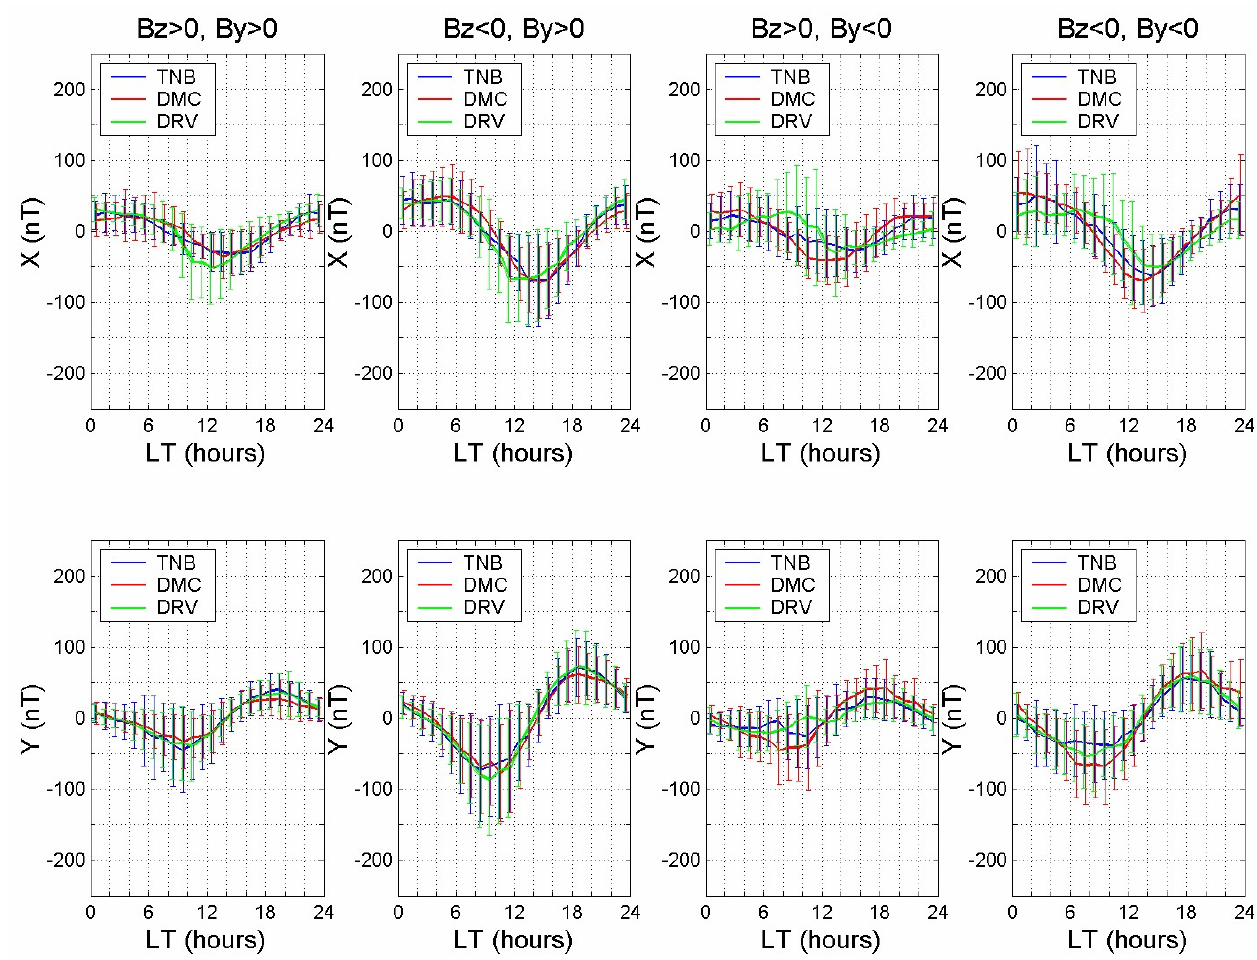
Fig. 9. Daily distribution of the average hourly values and their standard deviation for the X and Y components, separately for positive and negative conditions of both B y and B z